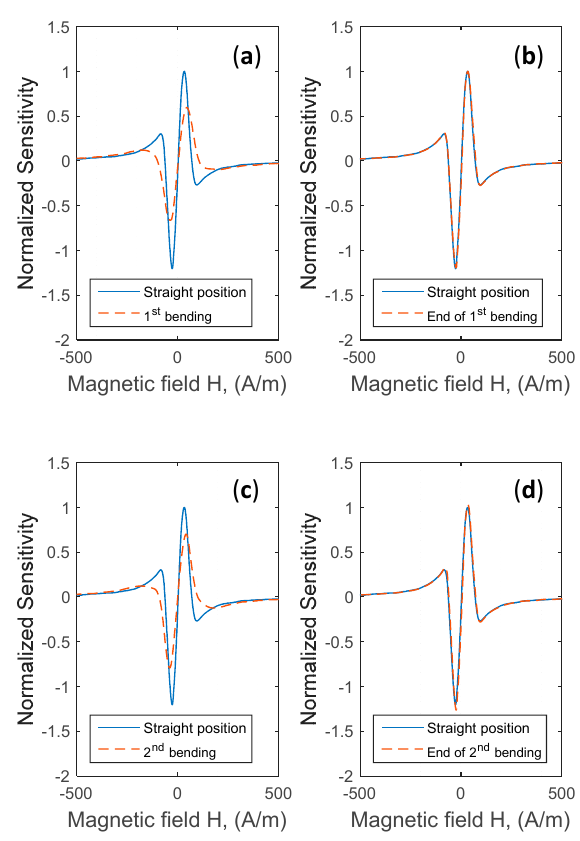
Figure 7. Reversibility and repeatability of the sensitivity following two consecutive bending stresses. ( a ) Change in the normalized sensitivity with a 1st bending stress; ( b ) Comparison between the normalized sensitivity after the relaxation of the bending stress (1st bending) and the initial straight position; ( c ) Change in the normalized sensitivity with a 2nd bending stress; ( d ) Comparison between the normalized sensitivity after the relaxation of the bending stress (2nd bending) and the initial straight position.